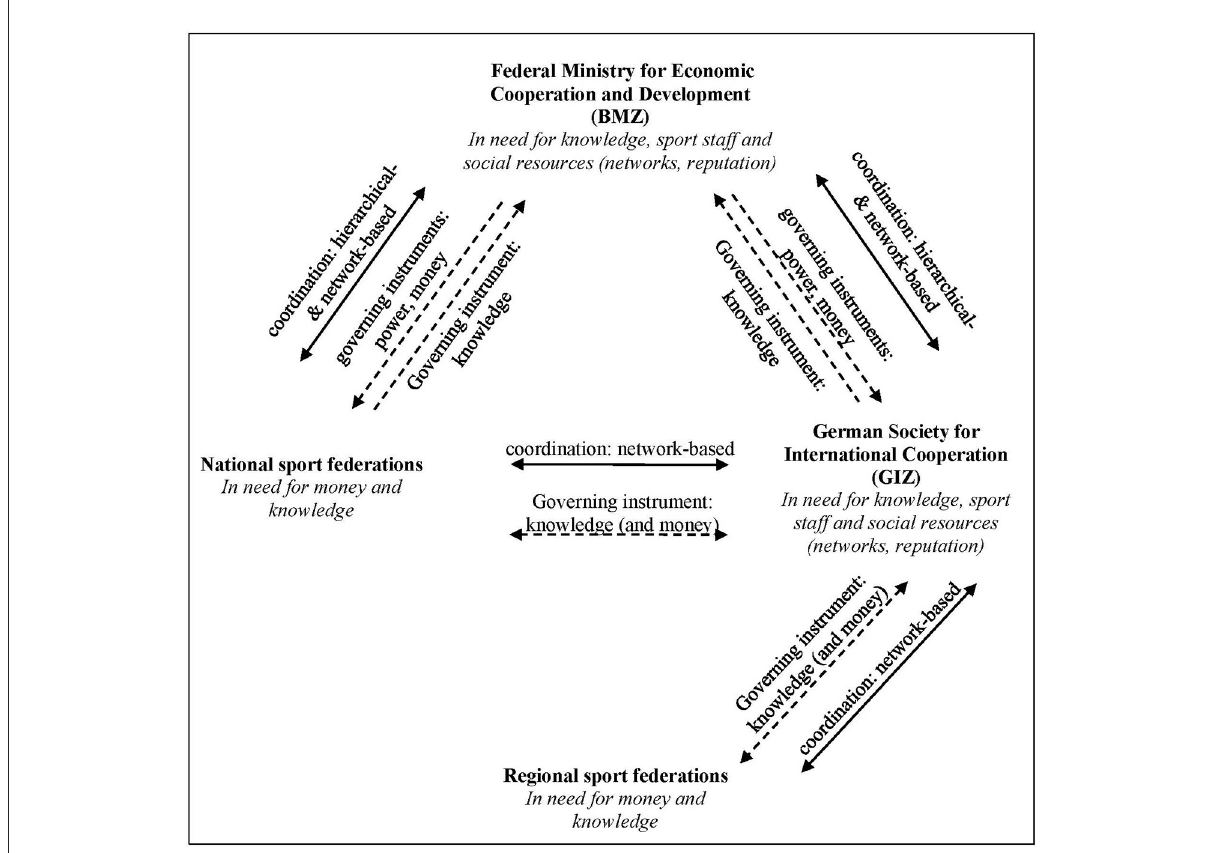
FIGURE3 Coordination processes, resources brought in, and governing instruments